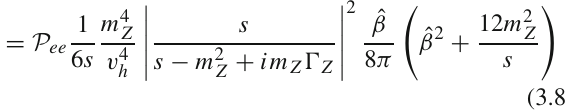
Table 2 The resolutions for track momentum ( σ 1 / p calorimeter ( σ 1 / E ) and hadronic calorimeter ( σ 1 / E ) Track